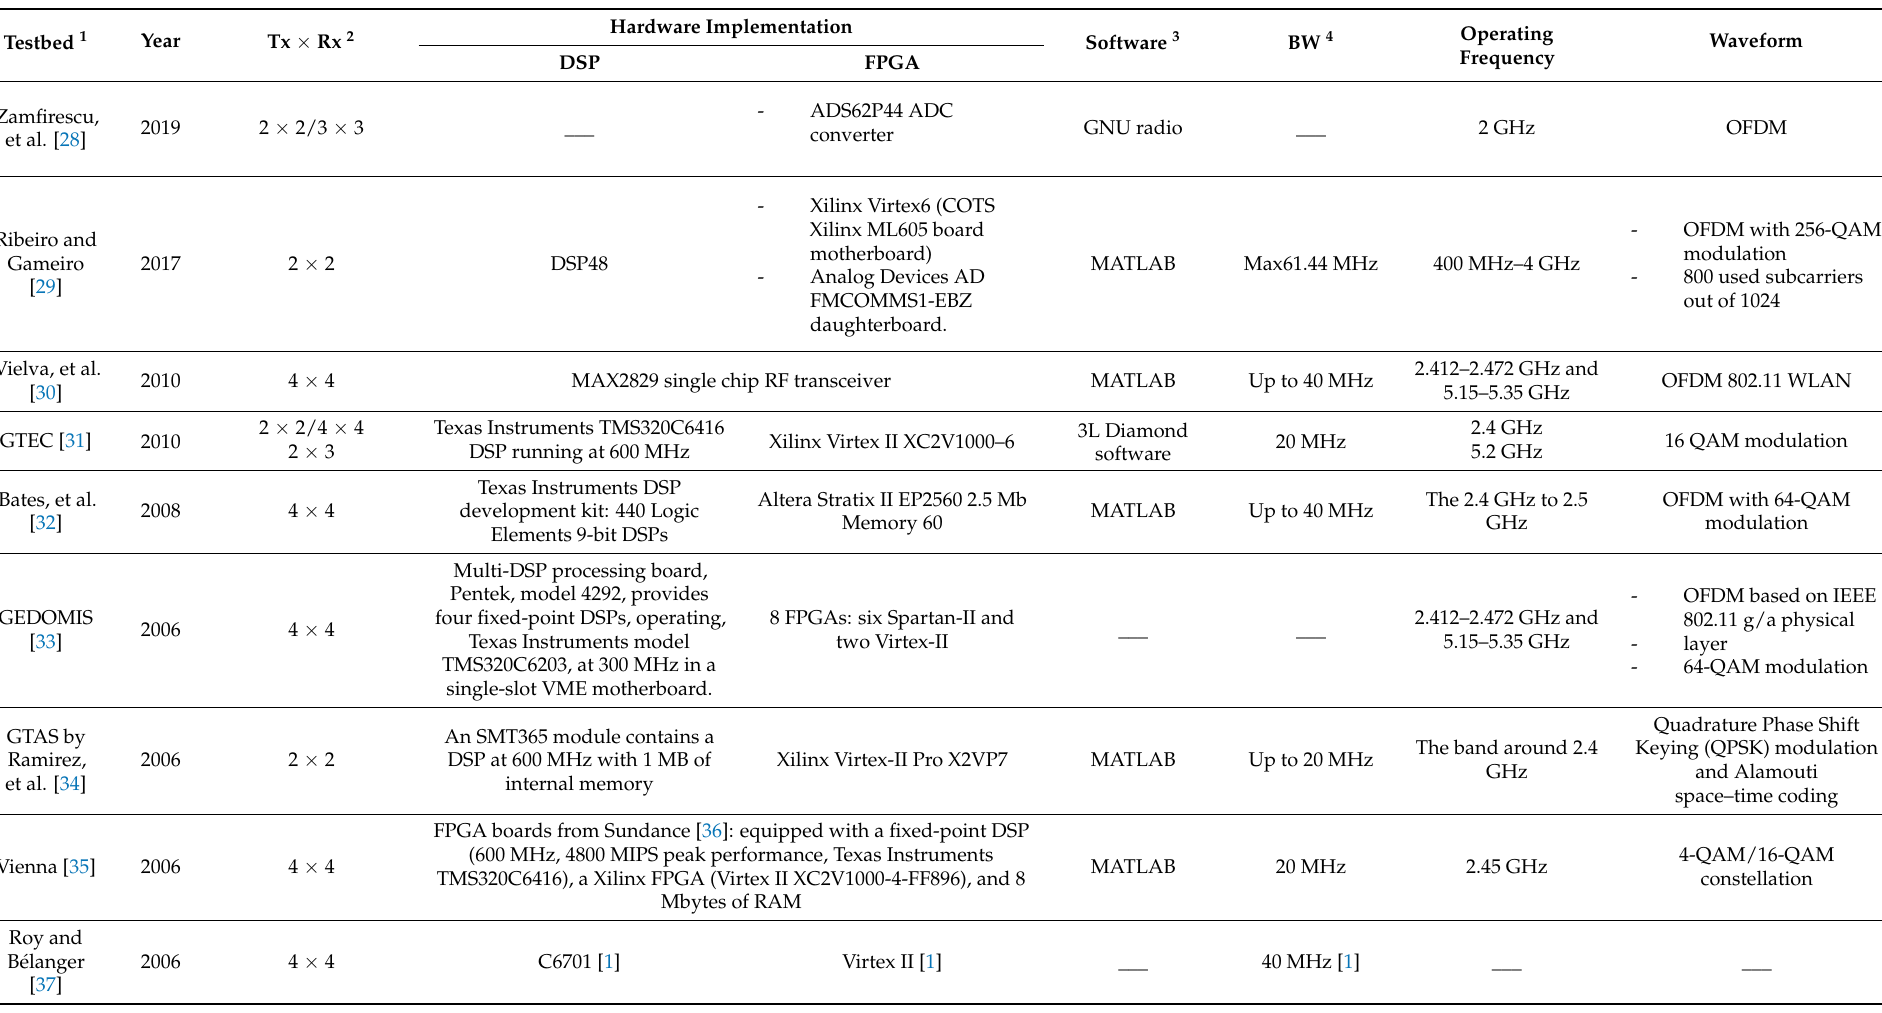
Table 2. Small-scale MIMO systems